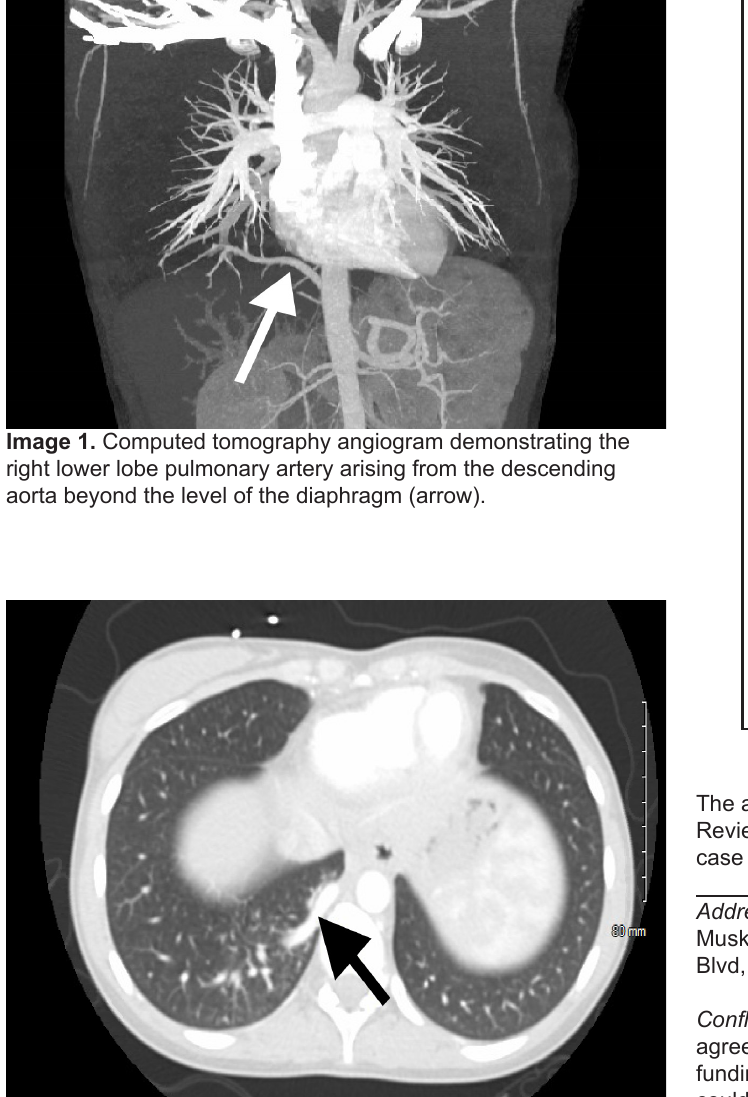
Image 2. There is no evidence of pulmonary embolism or aortic dissection on the computed tomography angiogram. Arrow shows anomalous pulmonary artery originating from descending